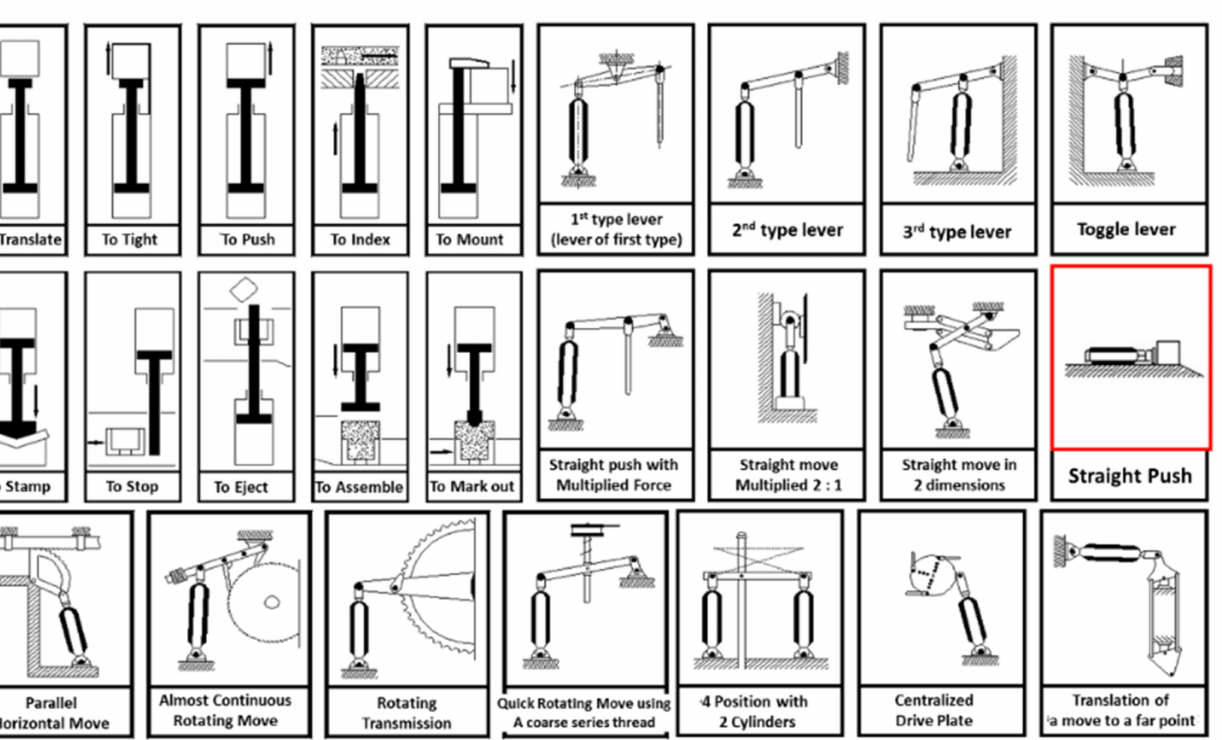
Figure 4. Pneumatic cylinder usages in